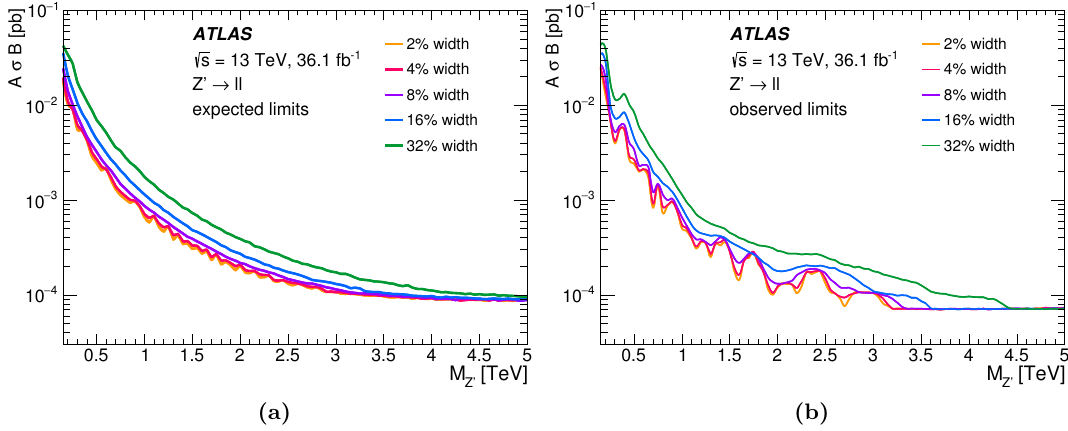
Figure 6 . Upper 95% CL limits on the acceptance times Z 0 production cross-section times branch- ing ratio to two leptons of a single (cid:13)avour as a function of Z 0 pole mass (M Z 0 ). (a) Expected and (b) observed limits in the combined dilepton channel for di(cid:11)erent widths with an applied mass window of two times the true width of the signal around the pole